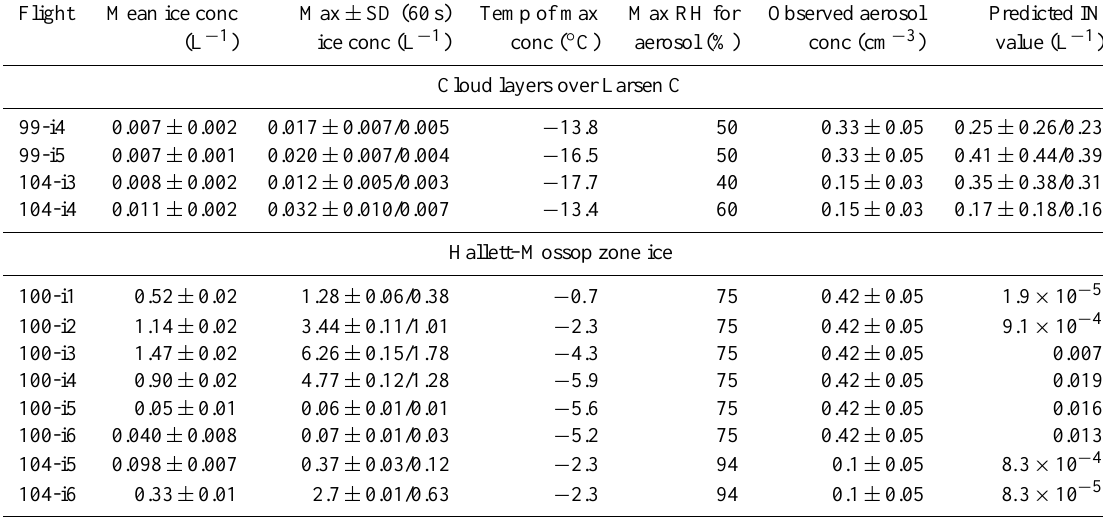
Table 3. Table reproduced from Grosvenor et al. (2012) reporting observations of ice number concentrations, aerosol concentrations >0.5µm and primary IN predictions using the D10